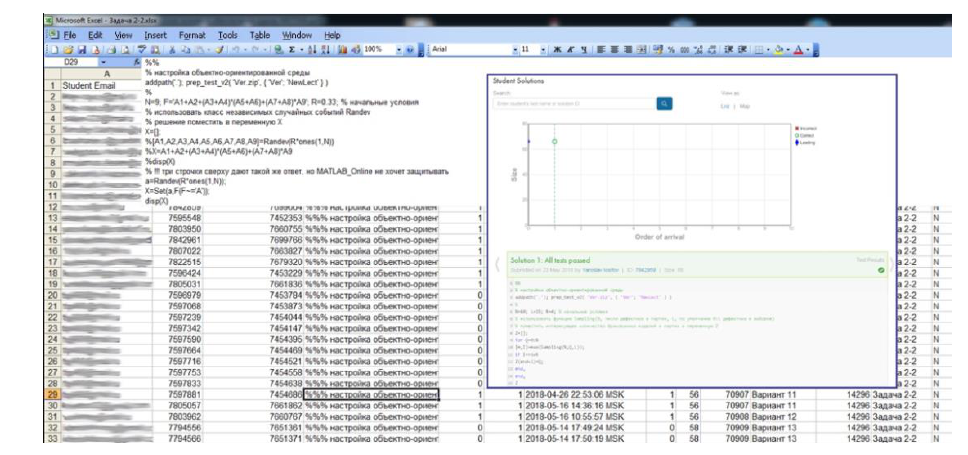
Fig. 6. Visual control of problem